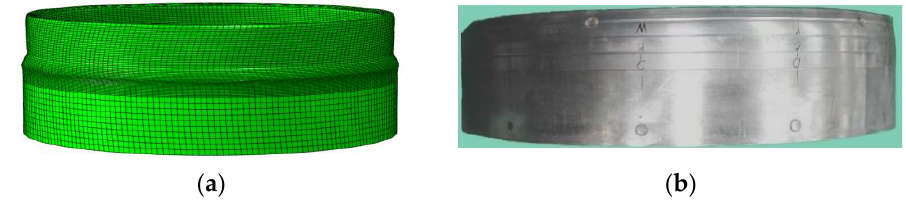
Figure 5. The final CRFF tubes: ( a ) Simulation; ( b ) Experiment.